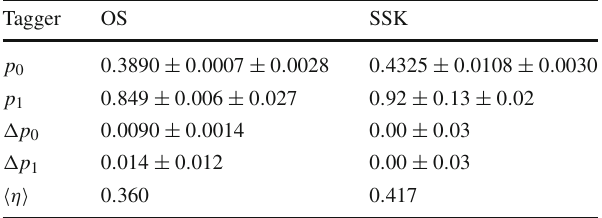
Table 1 Calibration parameters for the OS and SSK taggers. Where given, the first uncertainty is statistical and the second is systematic Tagger